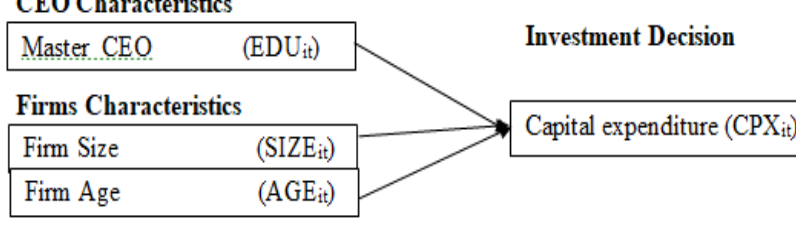
Figure 2. A conceptual framework for model 2